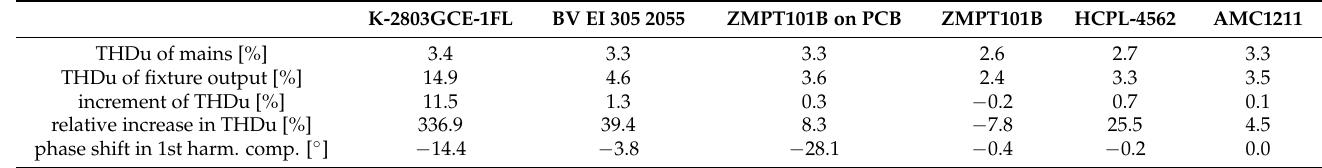
Table 2. THDu of mains and output signal, increment of THDu , relative increase in THDu , and a phase shift in the first harmonic component of input and output waveforms.